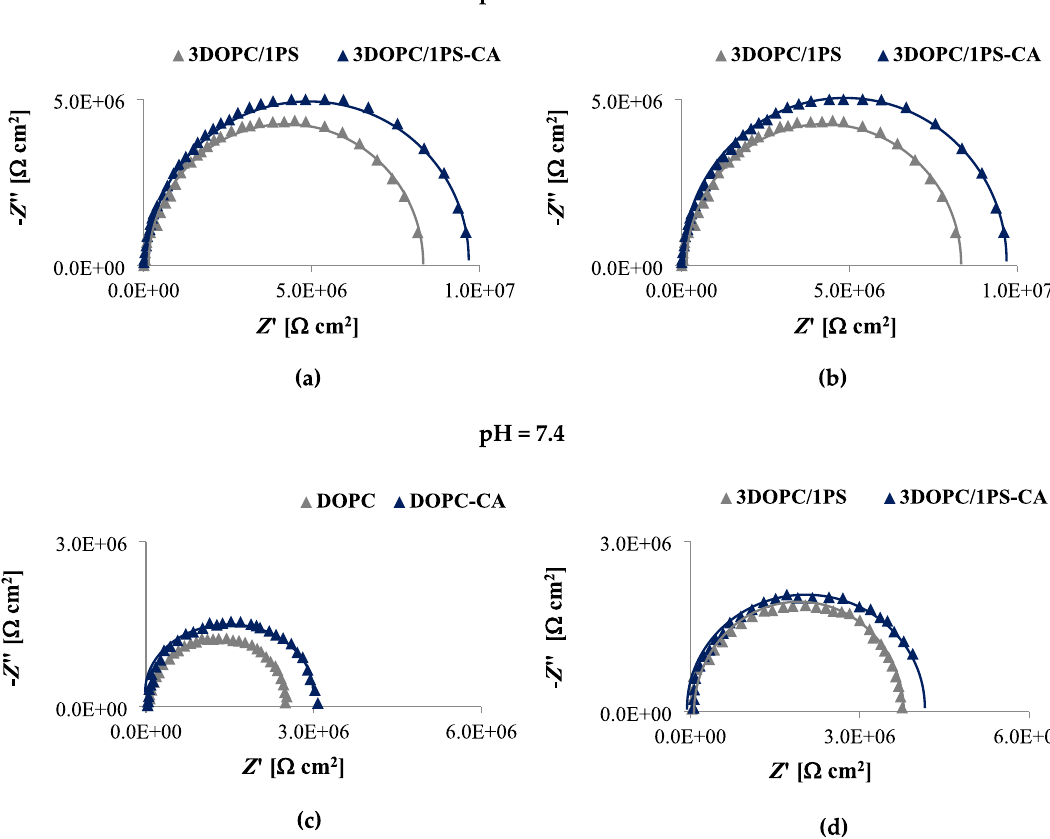
Figure 4. Impedance plots (experimental-dotted curve, and fitted-solid curve) obtained at pH = 3.0 ( a , b ) and pH = 7.4 ( c , d ) for: DOPC ( a , c ), and 3DOPC/1PS ( b , d ) bilayers as a function of 0 (grey) and 1 mmol/L (navy blue) concentration of caffeic acid.